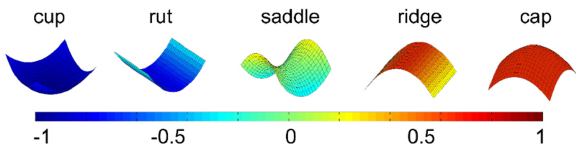
Figure 2. The surface morphology in the range of shape index.